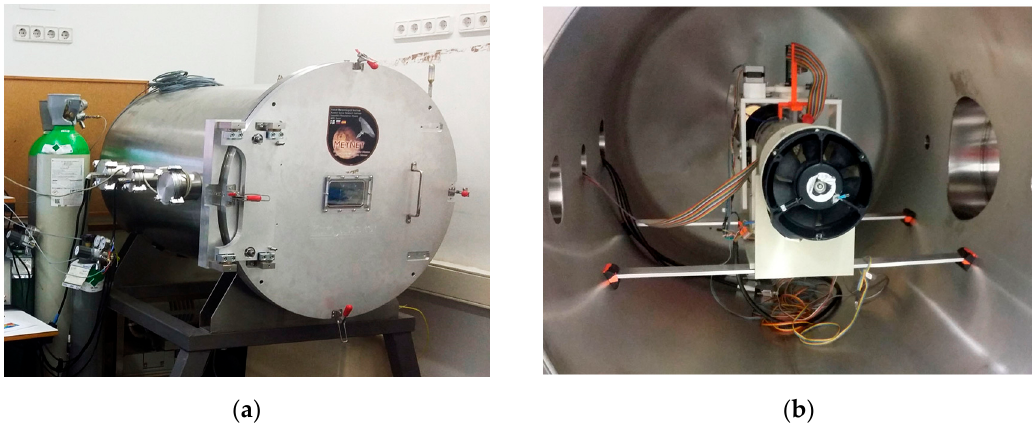
Figure 20. ( a ) High vacuum chamber and wind tunnel facility at the UPC; ( b ) Detail of the interior of the vacuum chamber. In the foreground is the fan that generates the wind inside the tube. The sensor is mounted, turned upside down, on the orange support, so the spherical head stays inside the tube. This support structure allows both changing the yaw and pitch angles of the sensor.